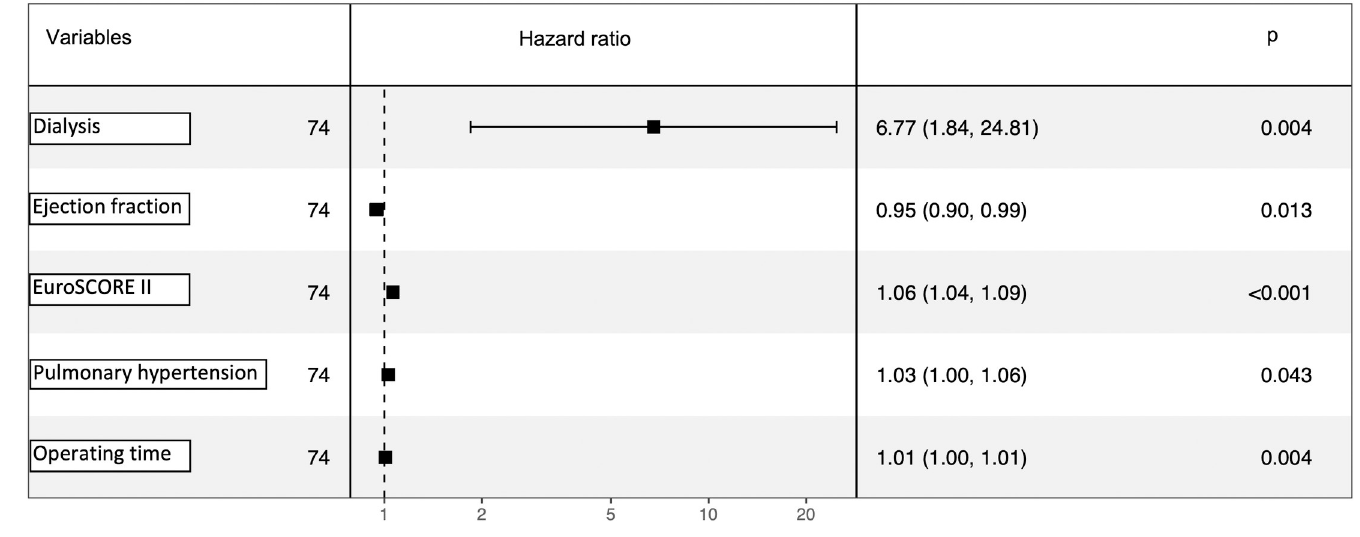
Fig 3. Cox-regression analysis.